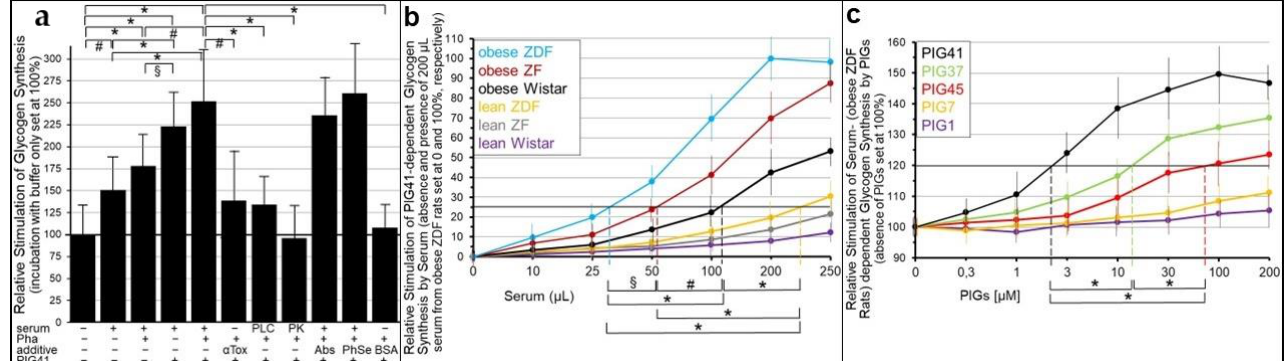
Figure 10. Stimulation of glycogen synthesis in ELCs by PIGs and serum GPI-binding proteins of metabolically dysregulated rats. ( a – c ) GPI-deficient EL acceptor cells were incubated (1 week, 37 °C, 5 mM glucose, 1 mM Ca 2+ ) in the bottom wells of transwell co-cultures with 200 μL buffer ( a , b ) or serum (( a , c ), 200 µL; b, increasing volumes), prepared from obese ZDF rats ( a , c ) or rats of different metabolic states ( b ) and then diluted 10-fold with PBS lacking (( a ), as indicated) or containing 2 mM Pha ( a – c ), which were left untreated (( a ), as indicated; b , c ) or incubated with proteinase K (PK), bacterial PI-PLC (PLC), α -toxin (α -toxin), anti-CD55, CD59, TNAP and CD73 antibodies (Abs), each coupled to Sepharose beads, phenyl Sepharose beads (PhSe) or 200 μL of BSA (4 mg/mL) ( a ), in the absence (( a ), as indicated) or presence of PIG41 (( a , b ) , 30 μM; c, increasing concentrations) or different PIGs ( c ). Thereafter, the ELCs were washed intensely by rinsing the bottom wells three times with 2 mL each of 20 mM Tris/HCl, 1.5 M NaCl and then two times with 2 mL each of PBS and subsequently assayed for glycogen synthesis (15 min, 37 °C, presence of BSA, 0.1 mM [U- 14 C]glucose) as described in Section 4. The experiment was repeated five to seven times (distinct incubations) with determination of glycogen synthesis in triplicate or quadruplicate. ( a ) The relative stimulation of glycogen synthesis by serum and PIG41 in the presence of Pha or other additives is given with incubation with buffer only set at 100%. ( b , c ) The relative stimulation of PIG41- ( b ) or serum (from obese ZDF rats)- ( c ) dependent glycogen synthesis by serum from metabolically different rats ( b ) or by different PIGs ( c ), respectively, is shown with the absence and presence of serum set at 0 and 100% ( b ) or the absence of PIGs set at 100% ( c ). Significant differences are indicated between the relative stimulations of glycogen synthesis under the various incubation conditions ( a ) or between the serum volumes effective in 25% (EV 25 , ( b )) or PIG concentrations effective in 20% (EC 20 , ( c )) stimulation of glycogen synthesis (horizontal, black lines), as indicated by vertical, hatched, and colored lines (means ± SD; * p ≤ 0.01, # p ≤ 0.02, § p ≤ 0.05).